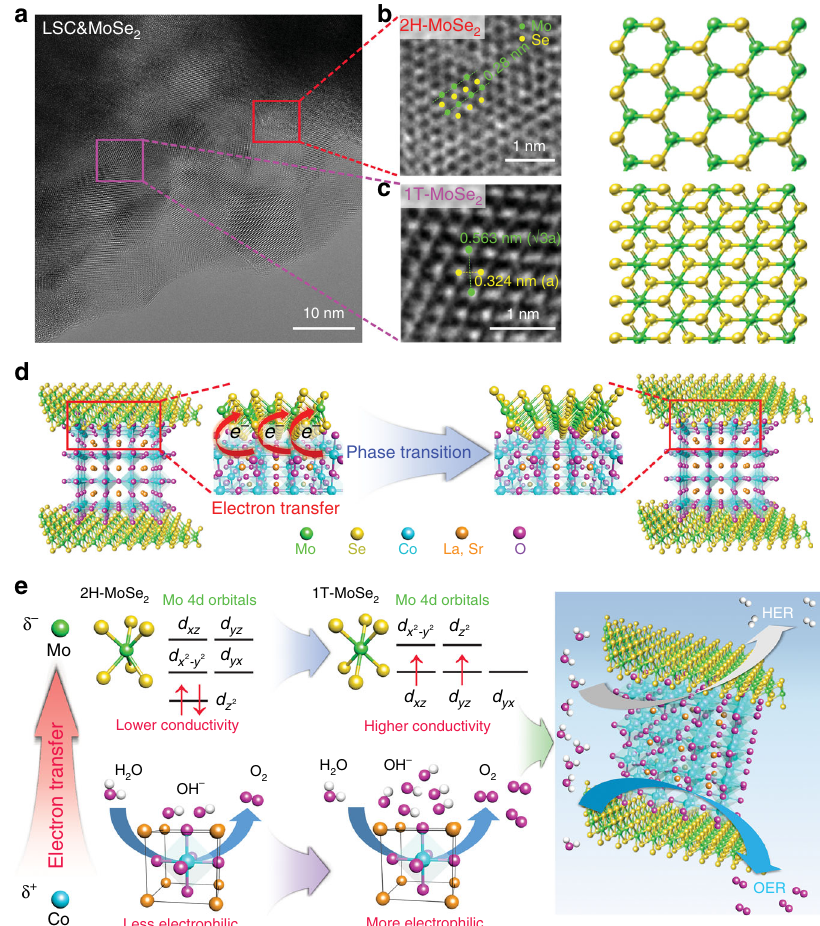
Fig. 4 Proposed mechanism describing potential interaction between MoSe 2 and LSC. a HR-TEM image of LSC&MoSe 2 , indicating the presence of both 2H- and 1T-Phase MoSe 2 . b Enlarged region of 2H-MoSe 2 shown with schematic lattice structure, illustrating the hexagonal crystal structure with Mo – Mo inter- atomic distance of 0.28 nm. c Enlarged region of 1T-MoSe 2 shown with schematic lattice structure, indicating the Mo – Mo (0.563 nm) and Se – Se